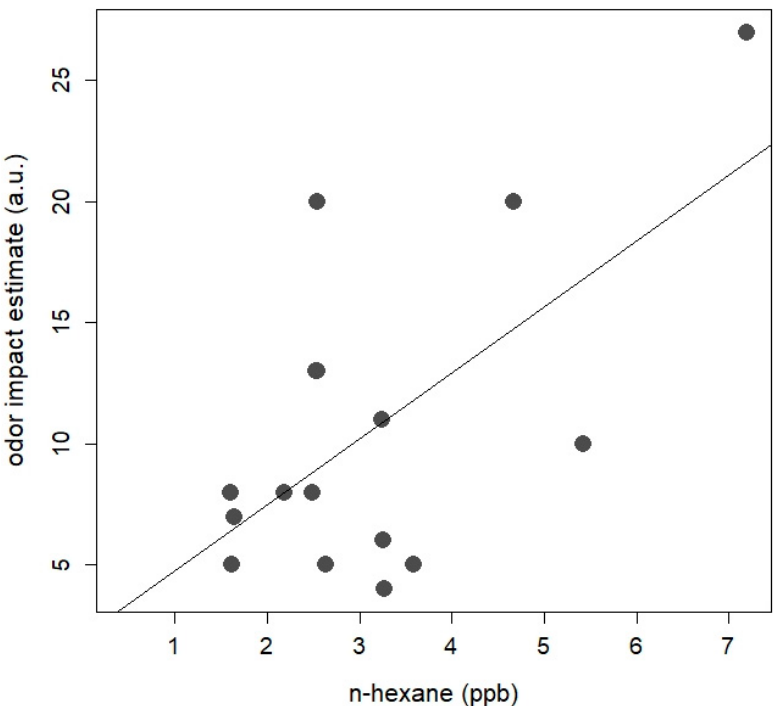
Figure 7. Correlation scatter plot between n-hexane observations and a derived odor impact estimate based on converting daily verbal odor descriptions into a weekly total number (r 2 = 0.34; p = 0.01).